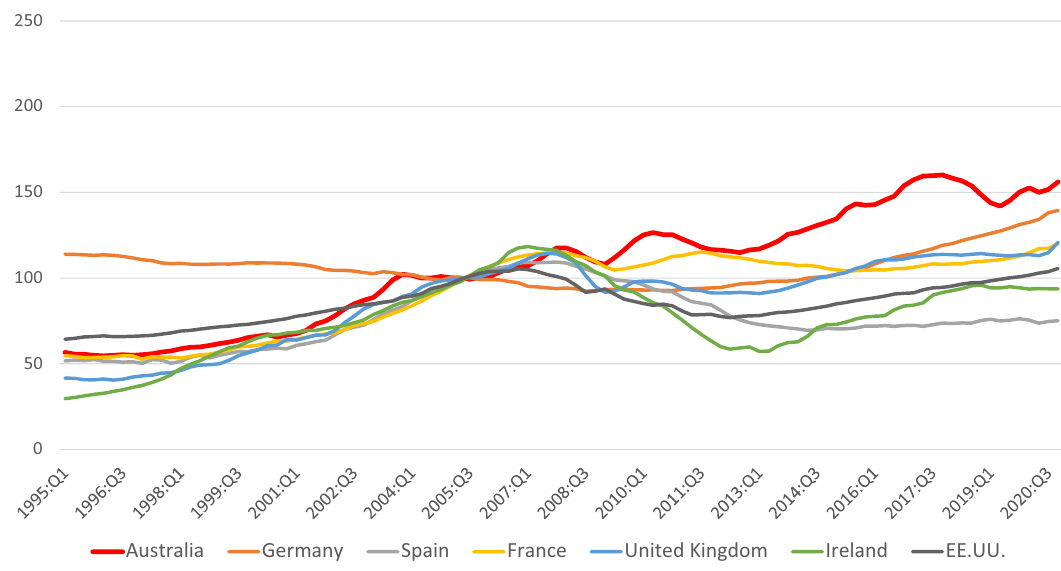
Figure 1: International Real House Price Index, 2005 = 100 1995:Q1 – 2020